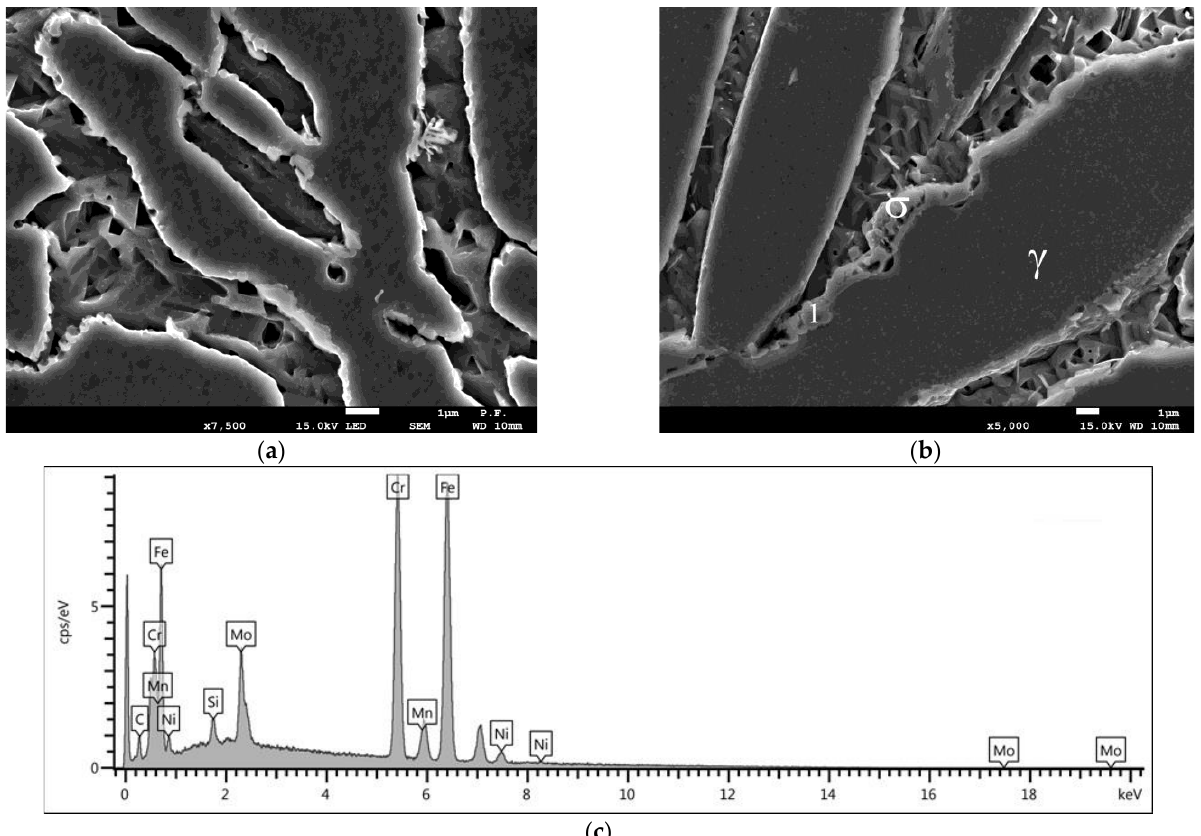
Figure 5. SEM image of microstructure of tested cast steel after holding at 750 °C for 1 h ( a ) and 3 h ( b ) (deep etching); ( c ) example of spectrum of precipitate occurring at γ / α interface (Point 1, b ); (scanning microscope).